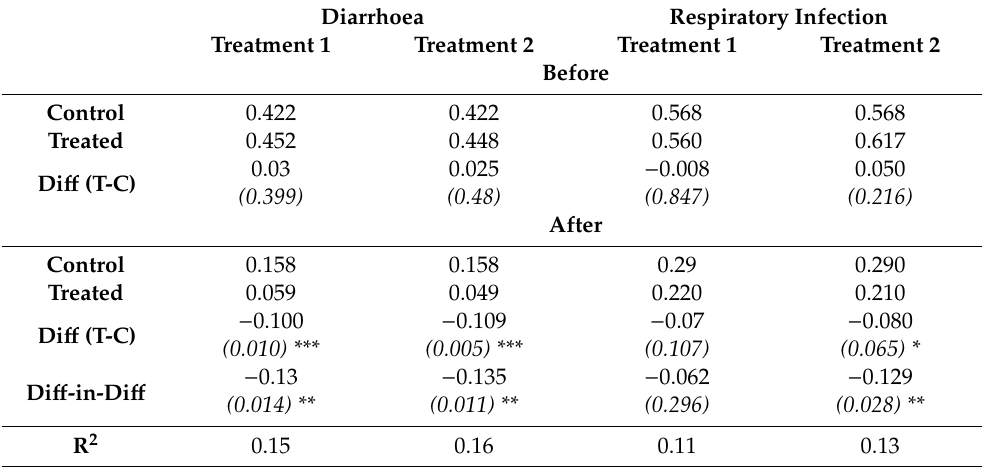
Table 5. Di ff erence in di ff erences analysis for diarrhoeal disease and respiratory infections. Diarrhoea Respiratory Infection Treatment 1 Treatment 2 Treatment 1 Treatment 2 Before Control 0.422